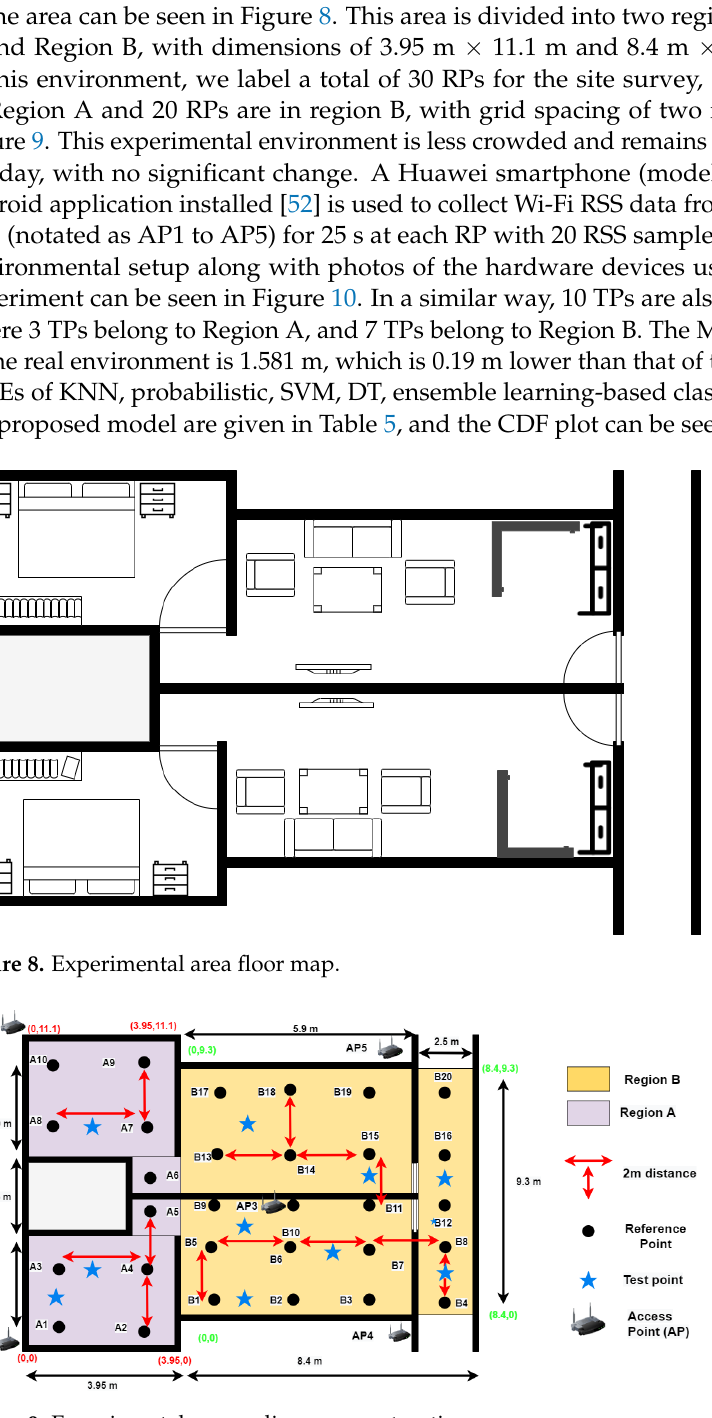
Figure 9. Experimental area radio map